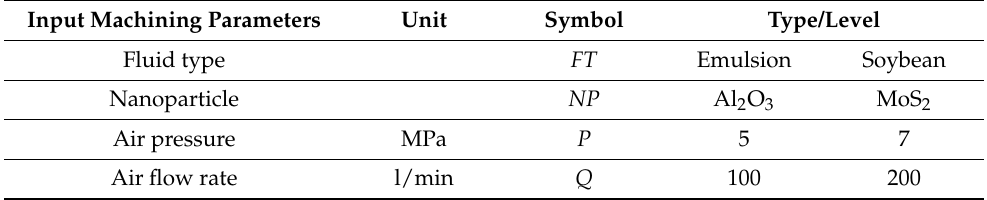
Table 1. Input machining parameters and their